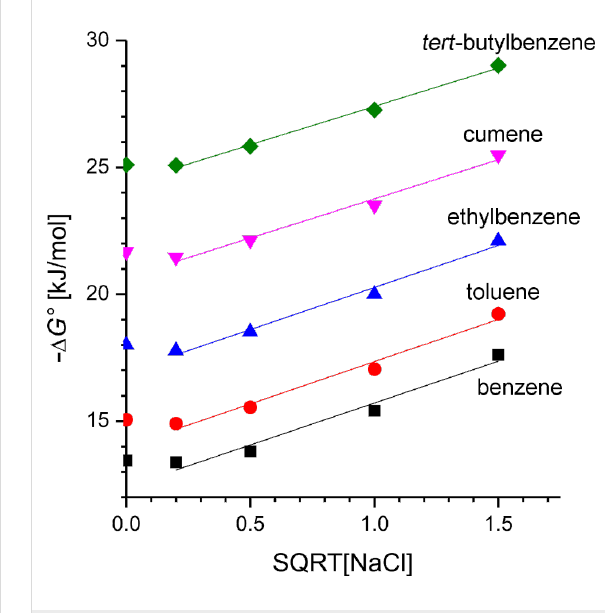
Figure 7: Free binding enthalpy for benzene, toluene, ethylbenzene, cumene, and tert -butylbenzene, in host 4 as a function of the square root of the salt concentration